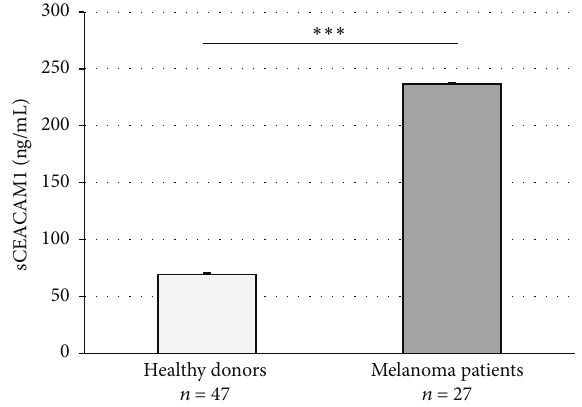
Figure 3: Serum CEACAM1 in healthy donors and melanoma patients. sCEACAM1 levels were assayed in the serum of 47 normal, healthy volunteers and in 27 melanoma patients. Statistics were assayed by regular Student’s 𝑡